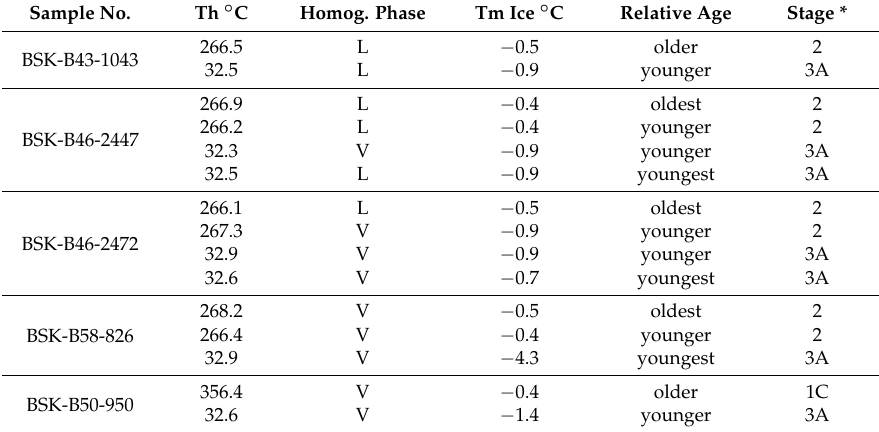
Table 4. Relative ages of cross-cutting